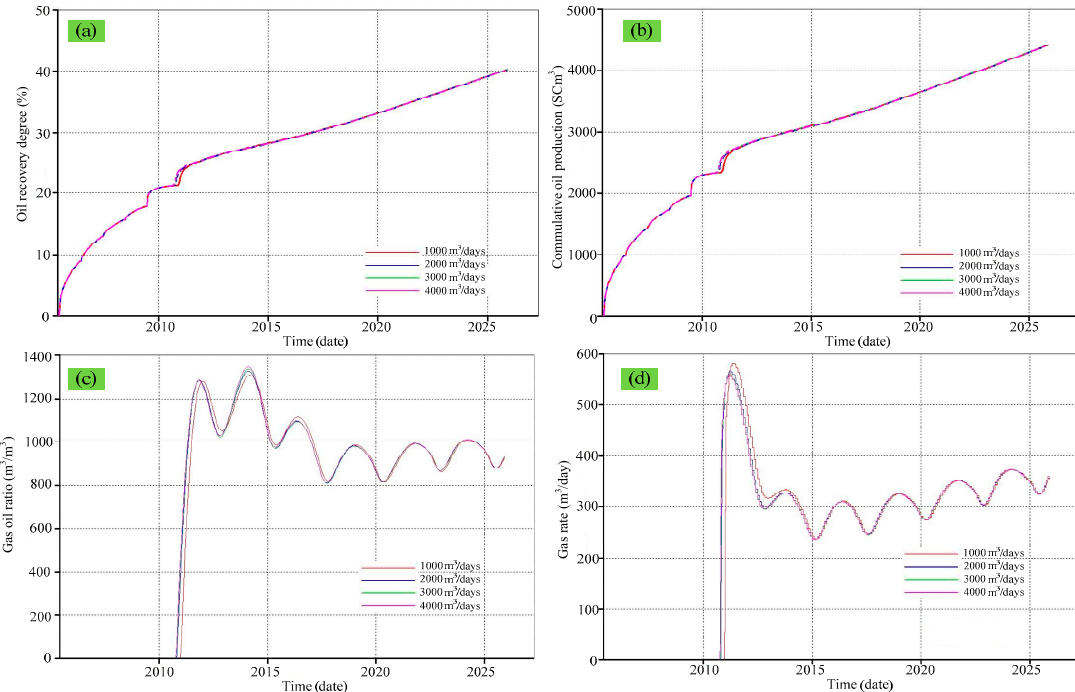
Figure 3. The temperature change of the firing front and oil saturation change under different huff and puff rounds. ( a ) Temperature change of the firing front; ( b ) oil saturation change.